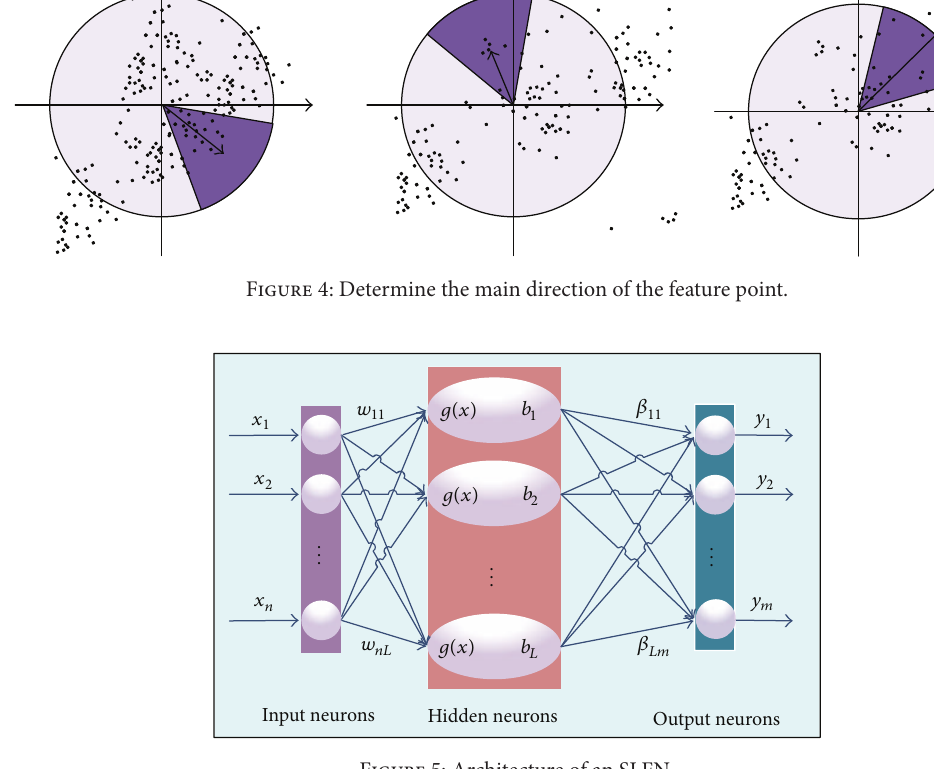
Figure 5: Architecture of an